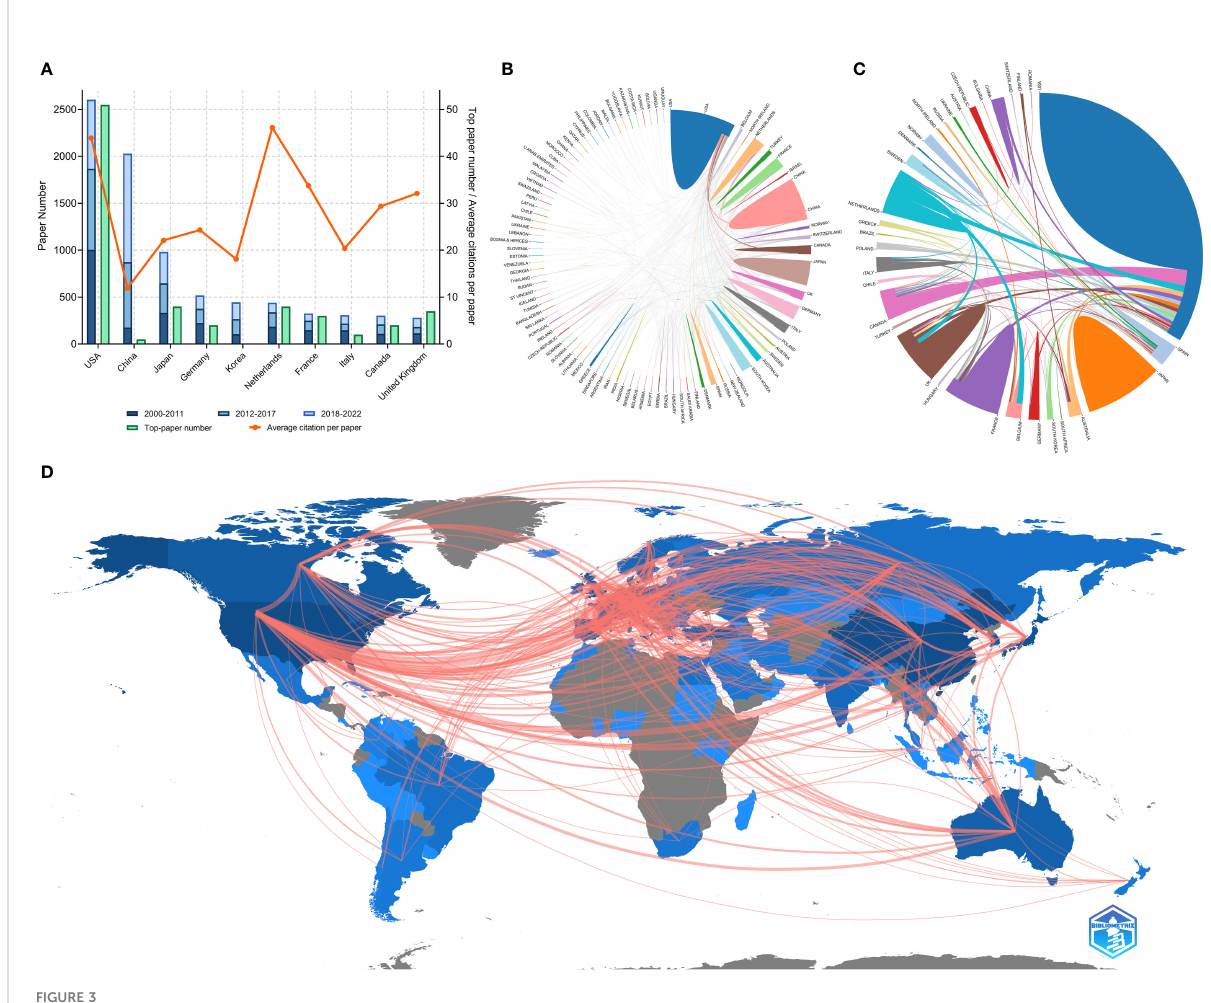
Supplementary Figure S4. “ immunotherapy ” , “ SBRT ” , and “ brain metastases ” are considered as emerging hot